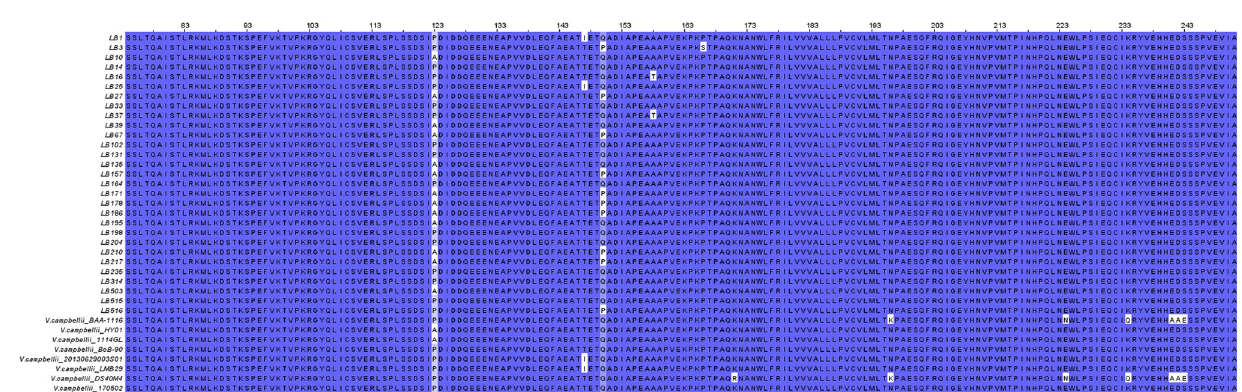
Figure 1. Maximum likelihood phylogenetic tree of luminescent bacterial isolates and other species under Harveyi clade was constructed using ( A ) 16S rRNA ( B ) rpoD ( C ) toxR and ( D ) concatenated sequence of 16S rRNA, rpoD and toxR . The tree was constructed at 1000 bootstraps replication and the length of each branch is proportional to the estimated number of substitutions per position. The tree is rooted using V. cholerae as outgroup. The 29 isolates of present study are represented by LB1 to LB516.